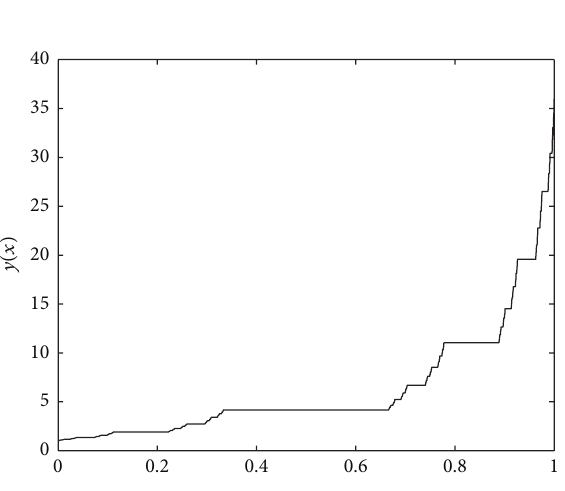
Figure 2: The graph of (22) with parameters 𝛽 = 1 , 𝜆 0 = 1 , and = 0 . 𝑡 0